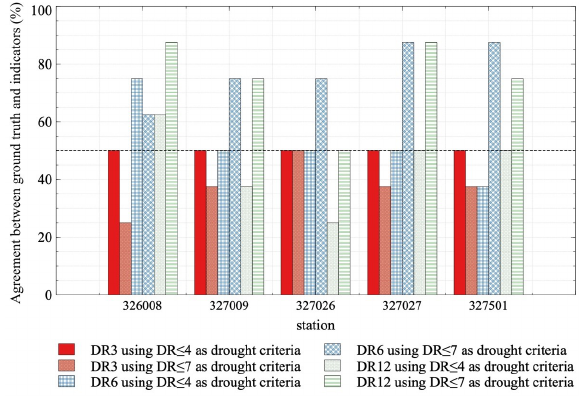
Fig. 6. Agreement between ground truth and drought indicators using DR ≤ 4 and DR ≤ 7 as drought criteria.